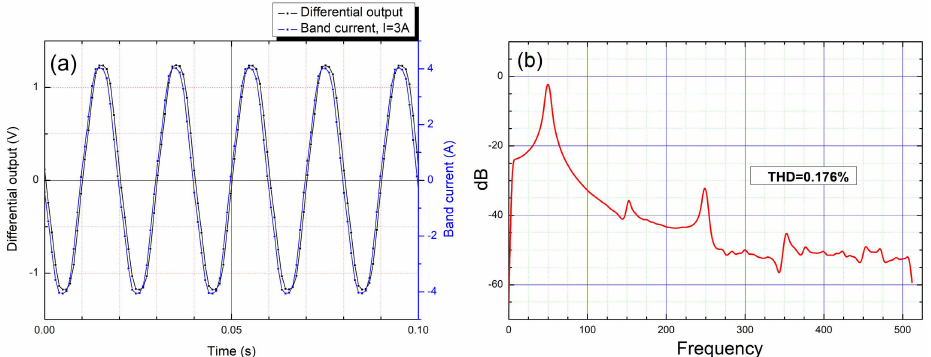
Figure 18. Biased sensors, AC 3A: ( a ) di ff erential response and band current; ( b ) harmonic analysis.